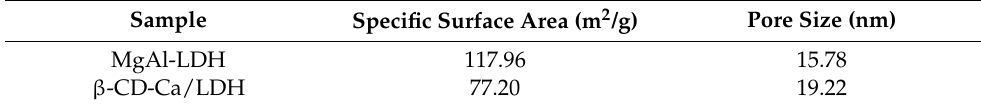
Table 4. Specific surface area and pore size of MgAl-LDH and β -CD-Ca/LDH.